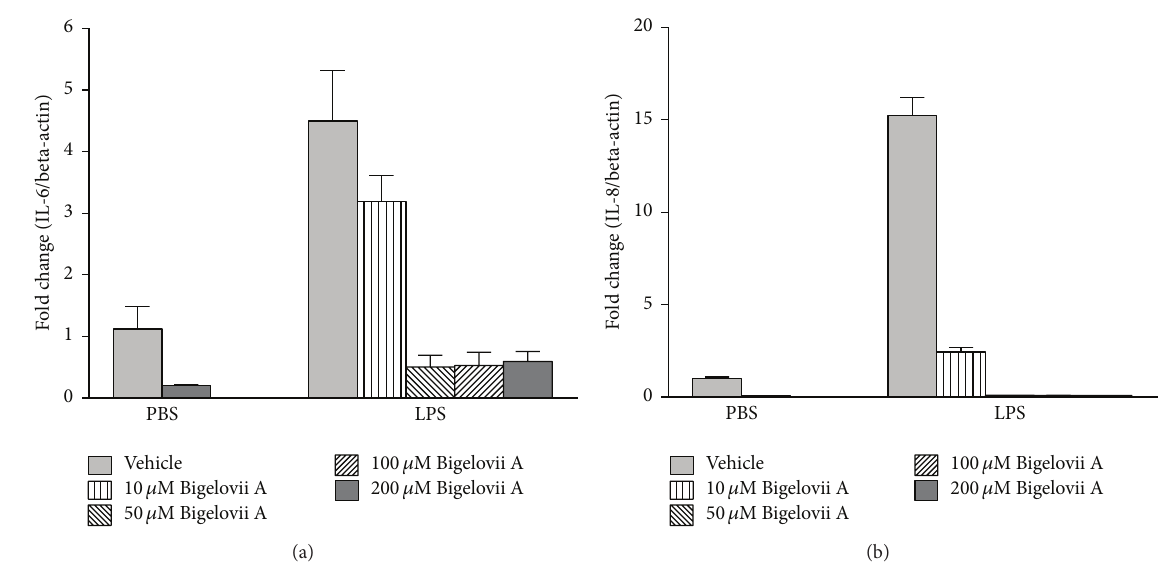
Figure 7: Effect of Bigelovii A on cytokine and chemokine expressions during LPS-induced inflammation in human-derived monocytes. THP-1 cells were pretreated with the indicated dose of Bigelovii A for 1h, followed by treatment with PBS or 100 ng/mL of LPS for 2 h. mRNAs were then extracted. Real time PCR was conducted to measure the mRNA levels of IL-6 (a) and IL-8 (b). Results are reflected by means ± SEM ( 𝑛 = 3 ).